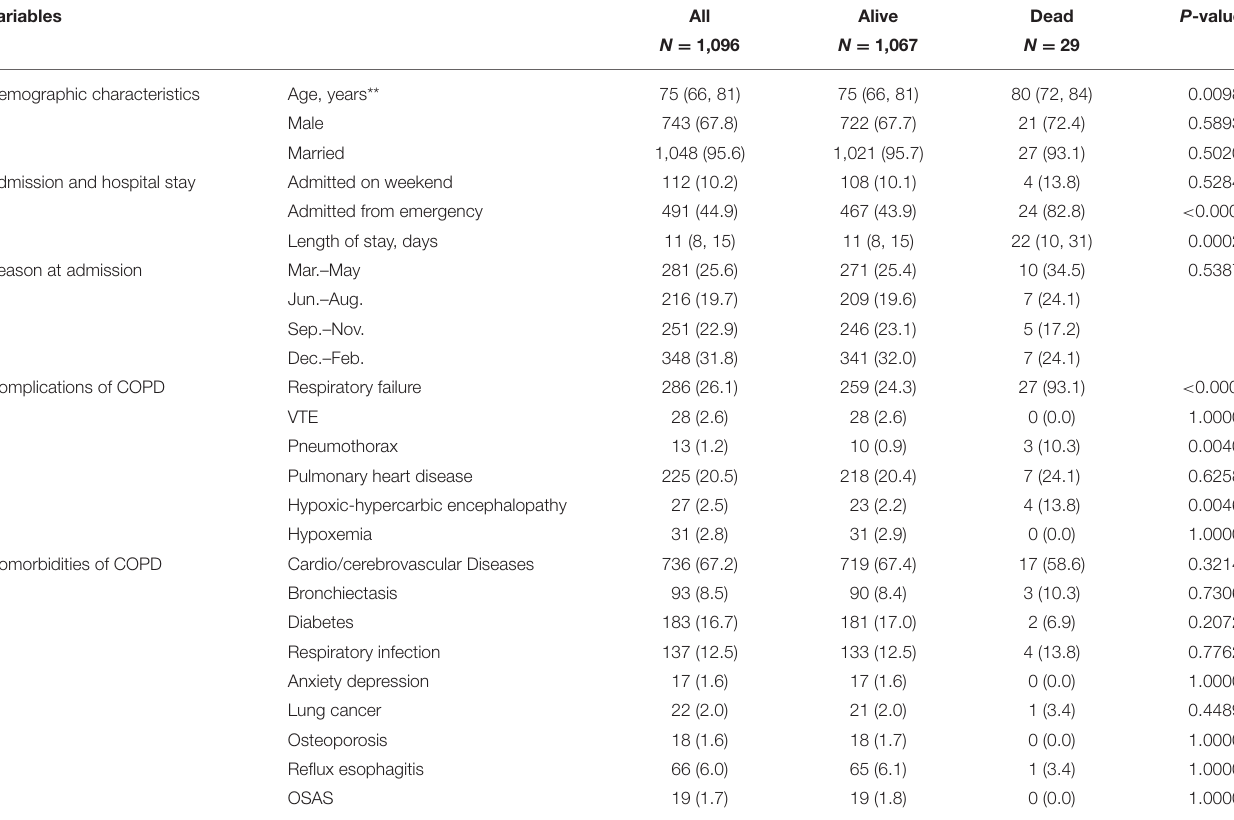
TABLE 1 | Characteristics of COPD patients hospitalized for acute exacerbation between 2015 and 2017. Variables